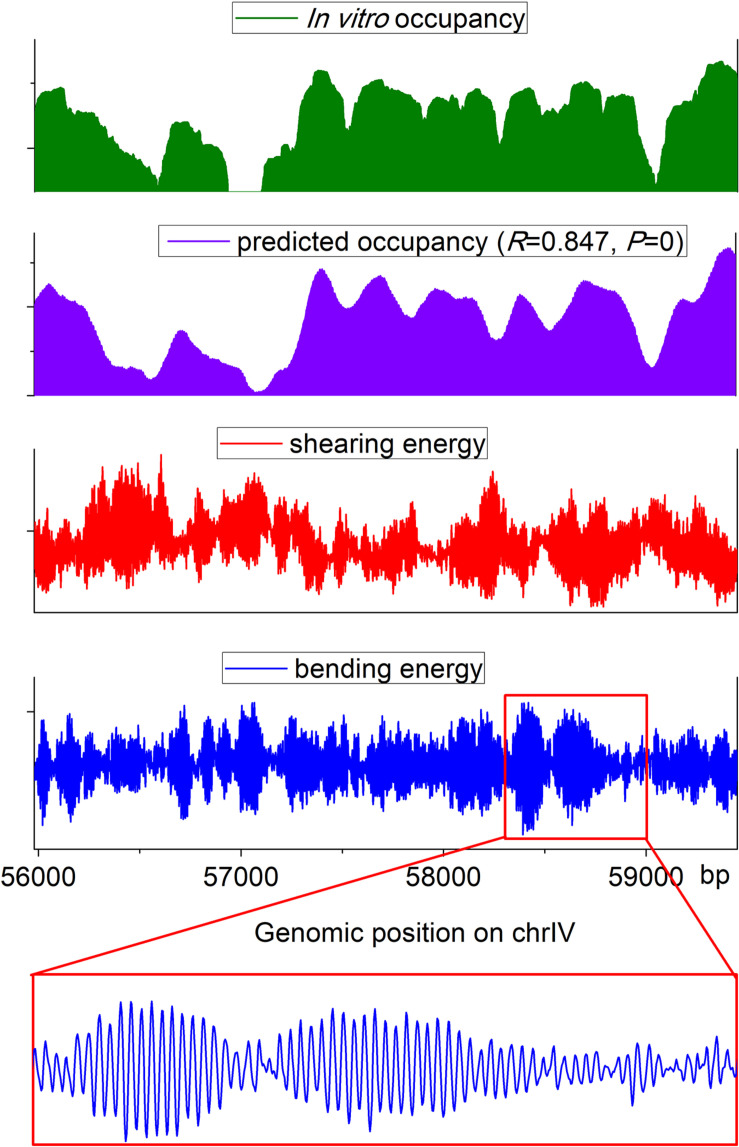
Landscape of estimated nucleosome occupancy, experimental nucleosome occupancy (Kaplan et al., 2009), and corresponding bending energy and shearing energy for a genomic region in budding yeast. The estimated occupancy shows a good agreement with the experimental map. Shearing energy was negatively correlated with the nucleosome occupancy, and the 10-bp oscillated bending energy profile can indicate the rotational positioning of a nucleosome.